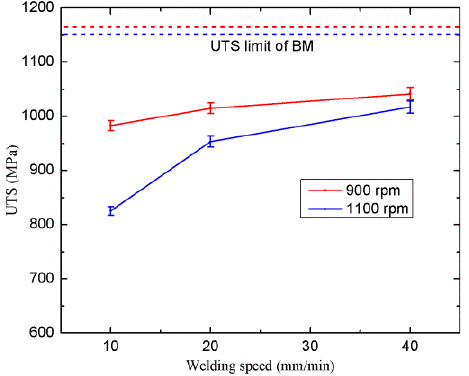
ff ect of parameters on UTS of FSWed Ti–6Al–4V Figure 14. Effect of parameters on UTS of FSWed Ti–6Al–4V joints. Figure 14. E Figure 14. Effect of parameters on UTS of FSWed Ti–6Al–4V joints.